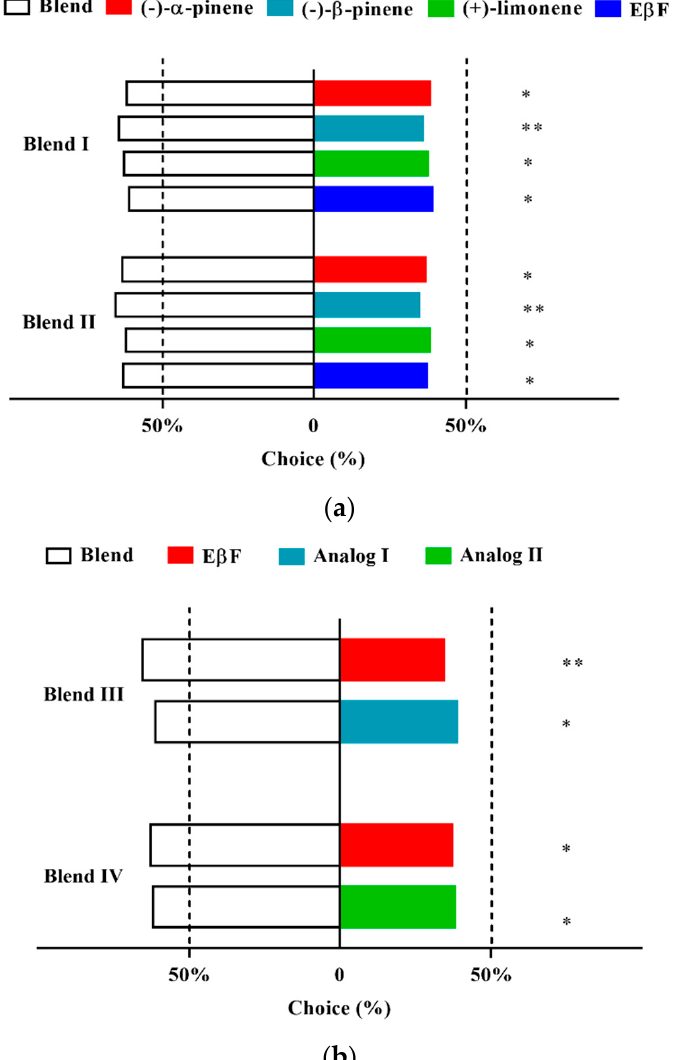
Figure 3. Two-way choice of Diaeretiella rapae between blends and single alarm pheromone components ( a ), and between blends and single compounds of E β F and its analogs ( b ). (* p < 0.05, ** p < 0.01).